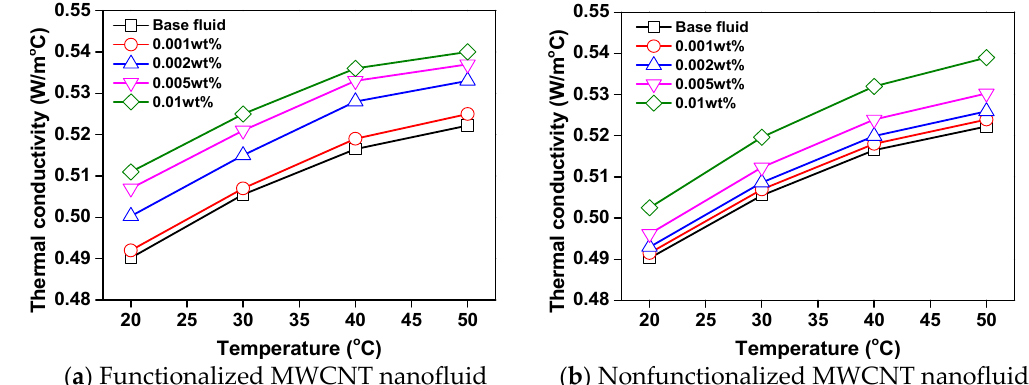
( b ) Nonfunctionalized MWCNT nanofluid Figure 8. Solar weighted absorption fraction of ( a ) functionalized and ( b ) nonfunctionalized MWCNT nanofluid. 3.2. Thermal Conductivity Characteristics of MWCNT Nanofluid The variation of the thermal conductivity of functionalized and nonfunctionalized MWCNT nanofluid is presented in Figure 9. The thermal conductivity of the MWCNT nanofluid increased with the increase of temperature. Furthermore, adding MWCNT nanoparticles into the base fluid can increase thermal conductivity significantly. In the case of the base fluid, the thermal conductivities of the ethylene glycol/water solution were 0.49 and 0.522 W/m o C at temperatures of 20 °C and 50 °C, that fits the ASHRAE [32] and Harkireat [36] results, respectively. Compared with the base fluid, the maximum increase of thermal conductivity was 10.15%, which was observed at a temperature of 50°C and a functionalized MWCNT nanofluid concentration of 0.01 wt%. The thermal conductivities of the functionalized and nonfunctionalized MWCNT nanofluid were 0.511 W/m o C and 0.502 W/m o C at 20 °C and 0.54 W/m°C and 0.538 W/m°C at 50 °C, respectively, when the concentration MWCNT